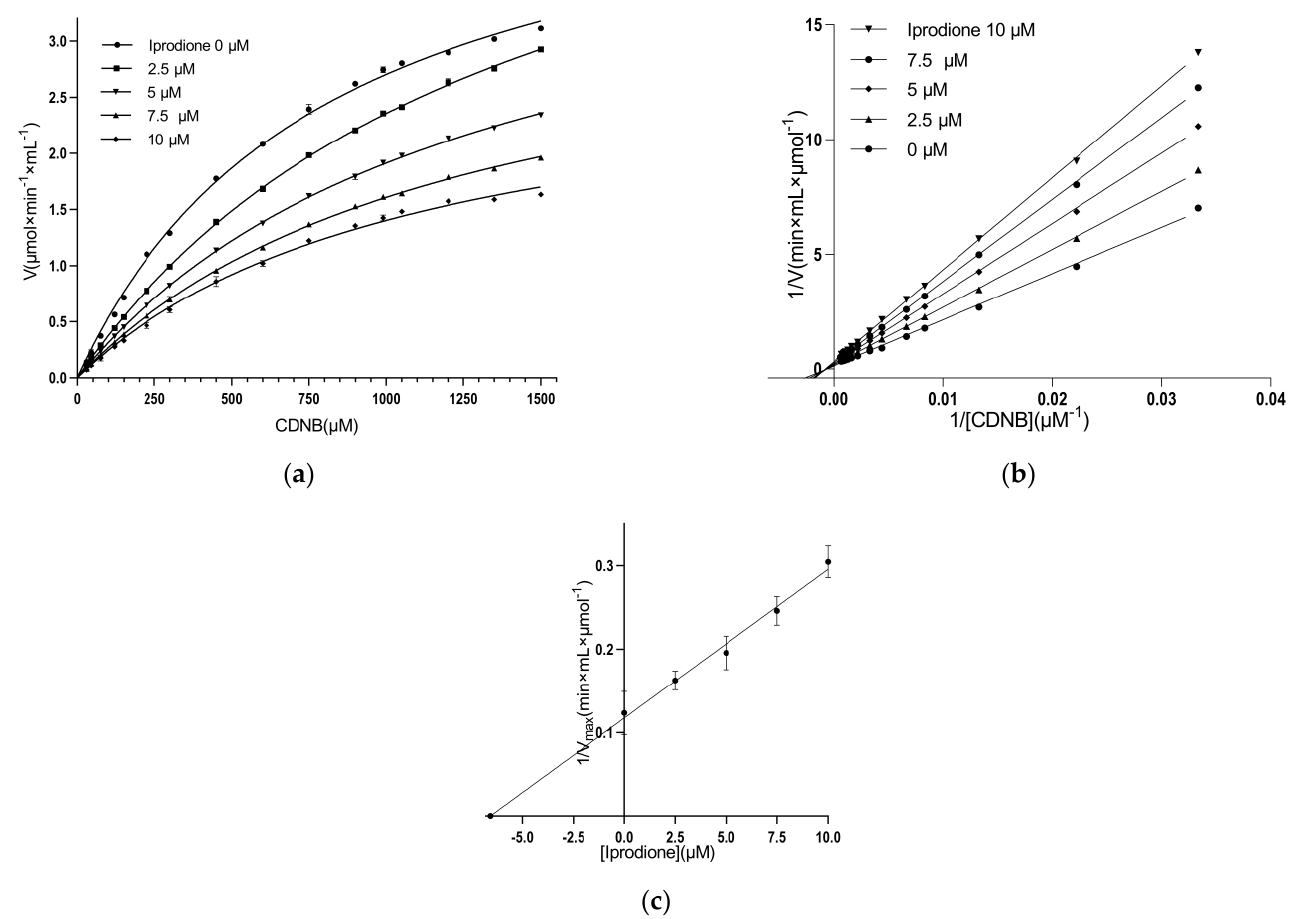
Figure 5. Kinetic inhibition study of Mm GSTP1 − 1 with iprodione. The concentration of GSH was constant, while the concentration of CDNB was varied. ( a ) Michaelis–Menten plot. ( b ) Lineweaver– Burk plot for inhibition. Iprodione concentrations: 0 − 10 μΜ. ( c ) Secondary plot for K i determination.